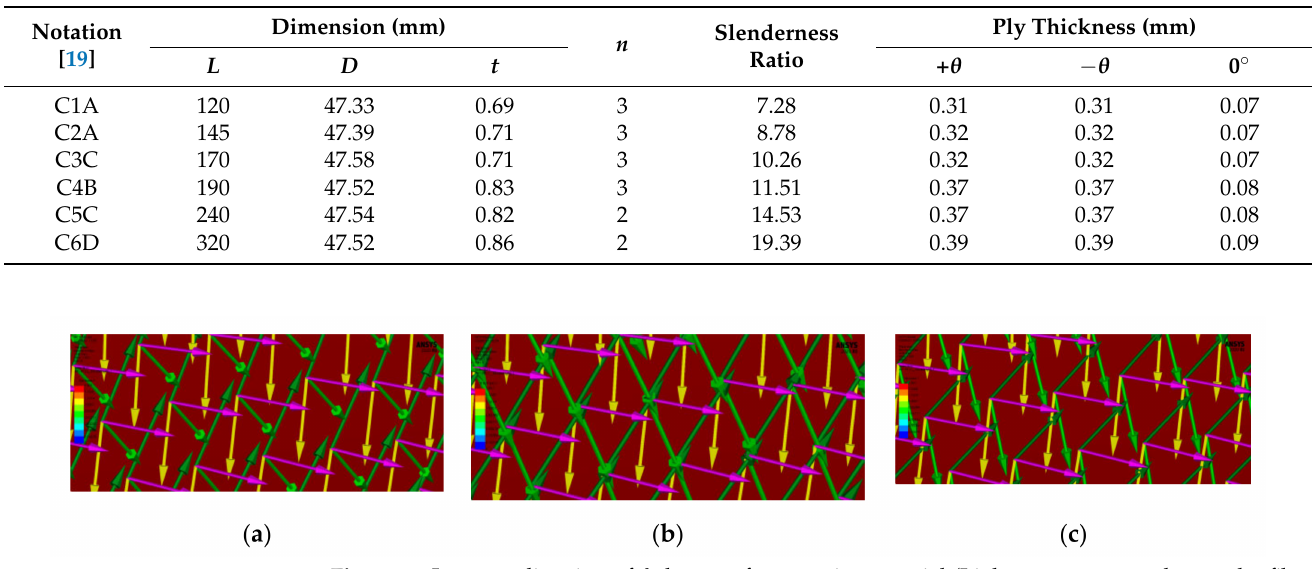
Figure 8. Lay-ups direction of θ degree of composite material (Light green arrows denote the fibre direction; Green arrows denote the transverse direction of fibre, and purple indicates the normal (out of plane) direction in defining orientation for ANSYS ACP). ( a ) − 30 degree, ( b ) − 45 degree, ( c ) − 60